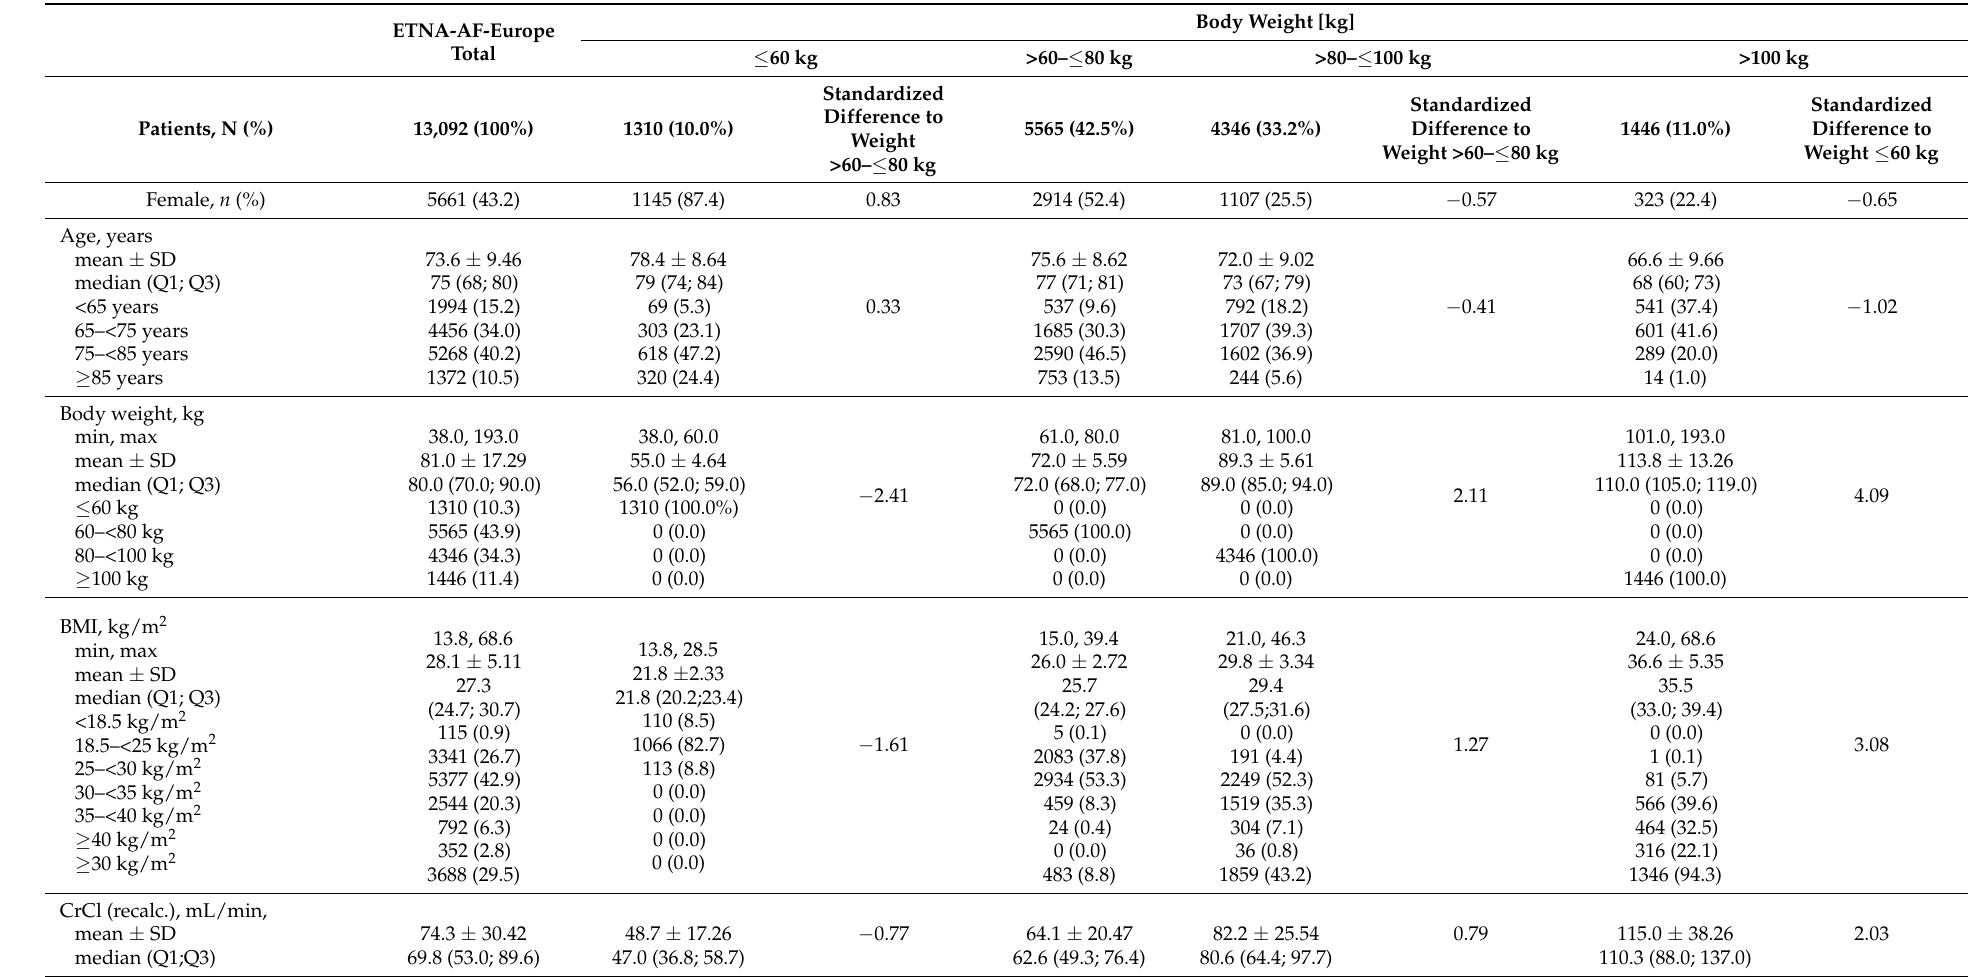
Table 1. Baseline demographics and clinical characteristics of patients included in ETNA-AF-Europe categorised by body